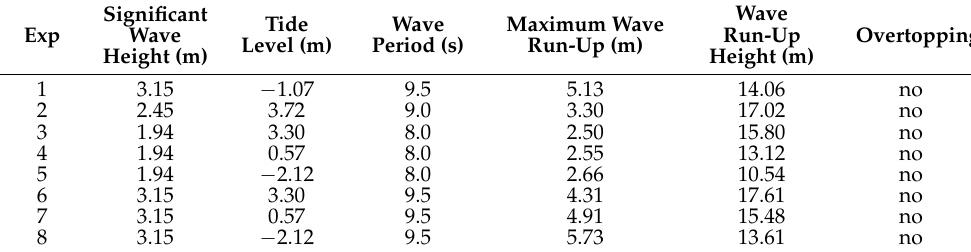
Table 3. Wave conditions and wave run-ups for Typhoon